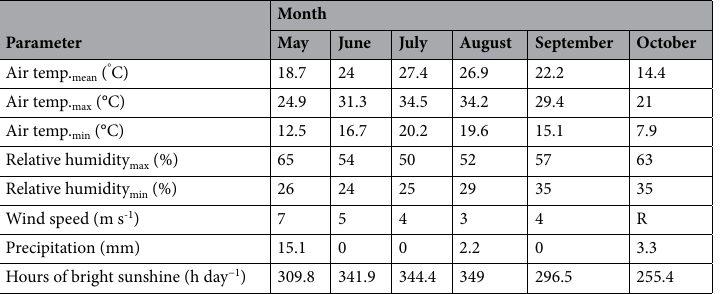
Table 5. Average and sum monthly weather parameters, during 2017 growing seasons 21 .